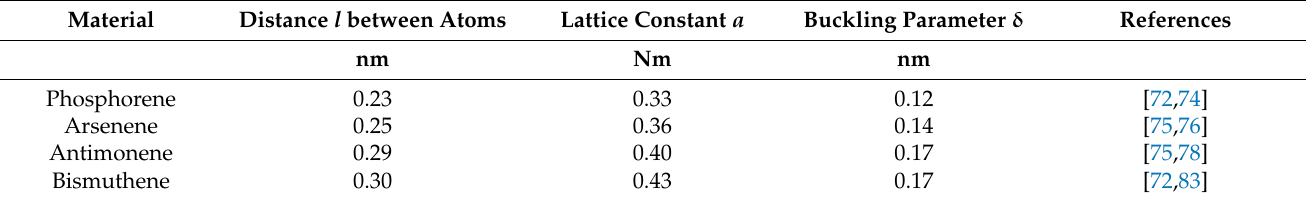
Table 3. Parameters of the honeycomb lattice of group VA transgraphenes.